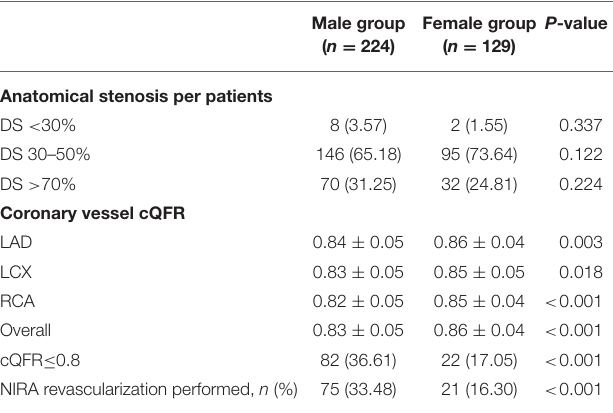
TABLE 3 | Clinical characteristics on QCA and